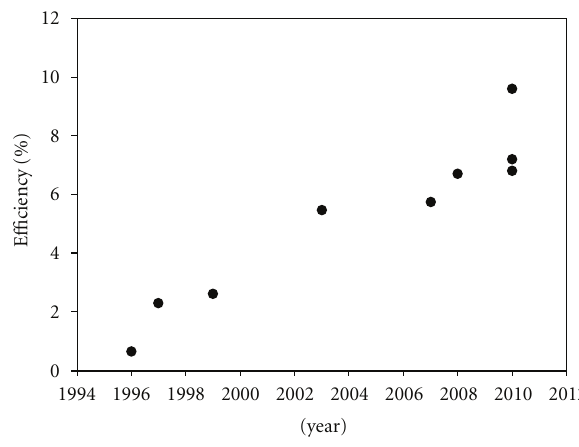
Figure 4: Evolution of the conversion e ffi ciency of thin film solar cells using CZTS as light absorber